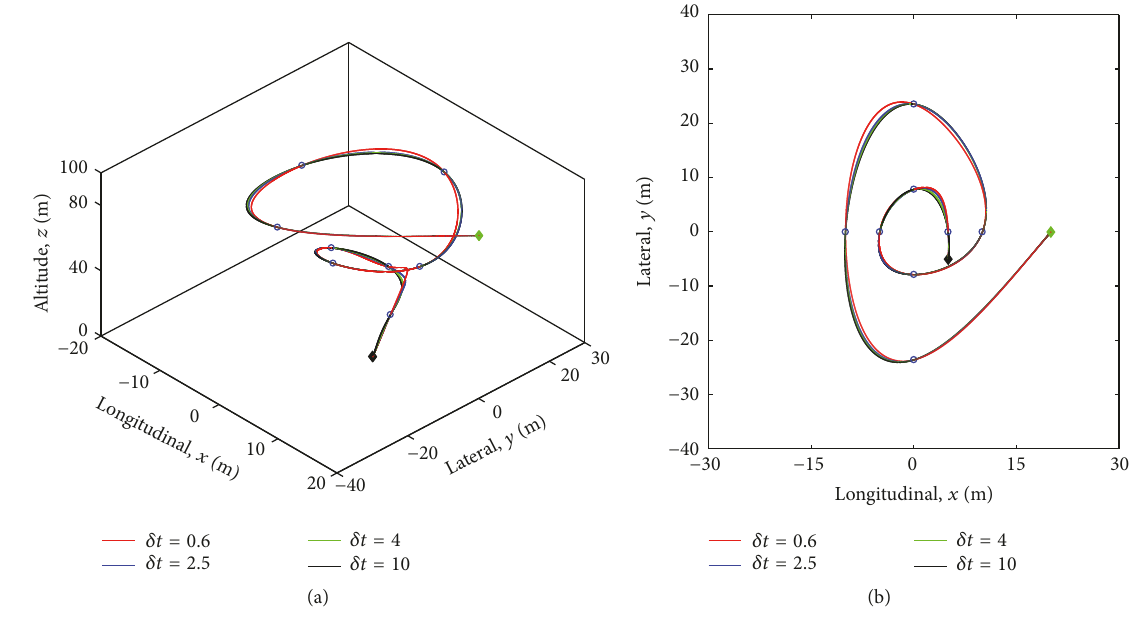
Figure 12: Optimal 3D and 2D reference flight trajectory.